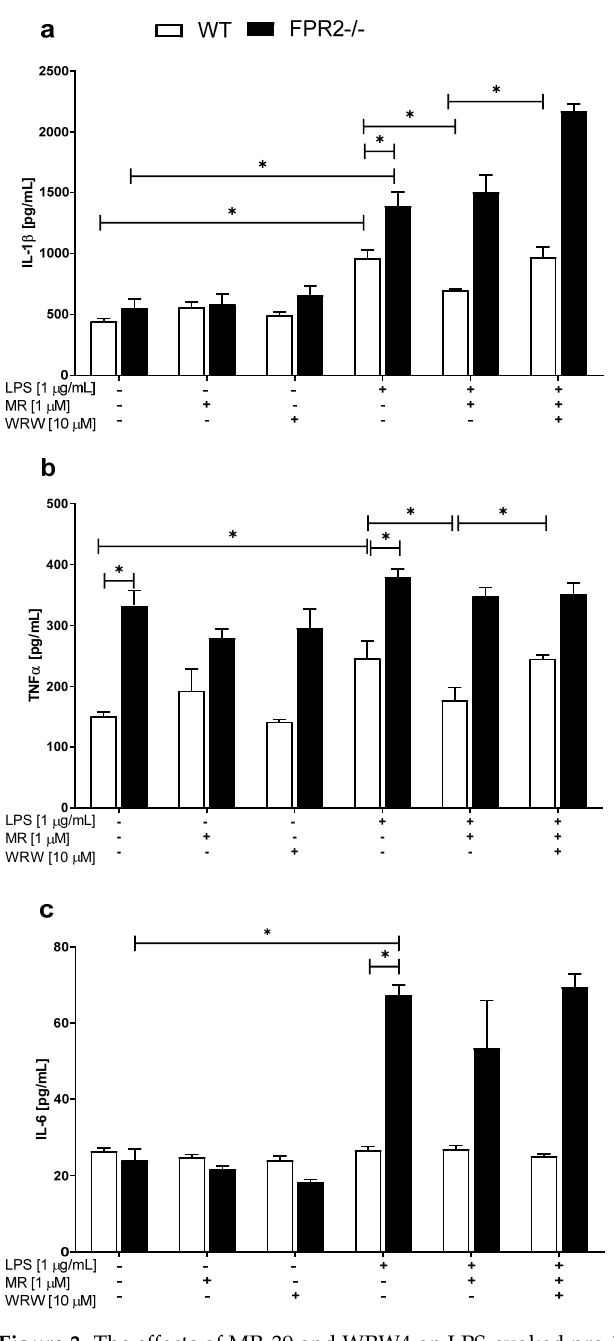
Figure 3. The effects of MR-39 and WRW4 on LPS-evoked pro-inflammatory cytokine release ( a —IL- 1 β ; b —TNF- α ; c —IL-6) in organotypic hippocampal cultures (OHCs) derived from the offspring of wild-type (WT) and FPR2 − / − (KO) mice. OHCs obtained from WT and KO mice were pretreated with the FPR2 antagonist WRW4 (10 µ M) for 30 min. Afterward, MR-39 (1 µ M) was added and incubated for 1 h, and then OHCs were stimulated with lipopolysaccharide (LPS; 1 µ g/mL) for 24 h. Control cultures were treated with the appropriate vehicle. The results are presented as the means ± SEM. The data were obtained from three independent experiments. The results were statistically evaluated using a factorial analysis of variance (ANOVA) with Duncan’s post hoc test to assess the differences between the treatment groups. Significant differences are indicated by * p <